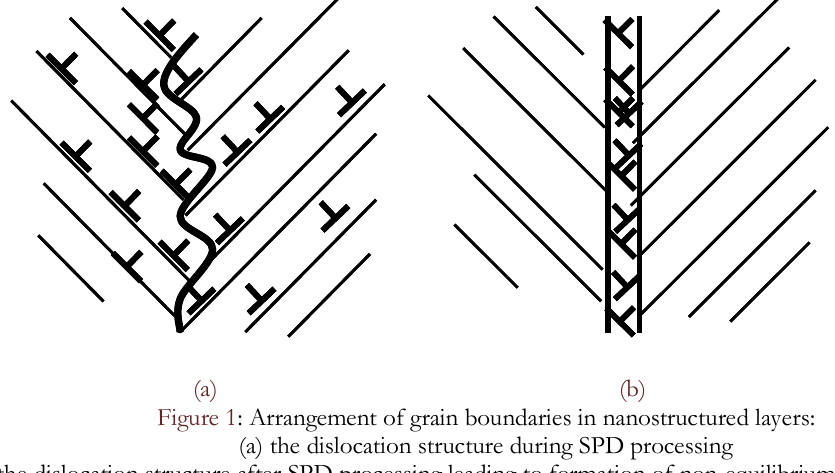
Figure 1: Arrangement of grain boundaries in nanostructured layers: (a) the dislocation structure during SPD processing (b) the dislocation structure after SPD processing leading to formation of non-equilibrium grain